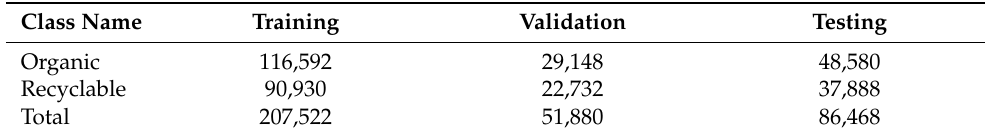
Table 2. Augmented dataset split for training, validation and testing the